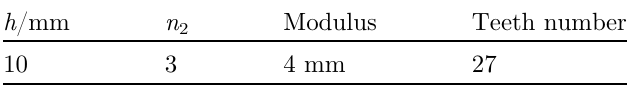
Table 2. Main parameters of high speed curve face gear.